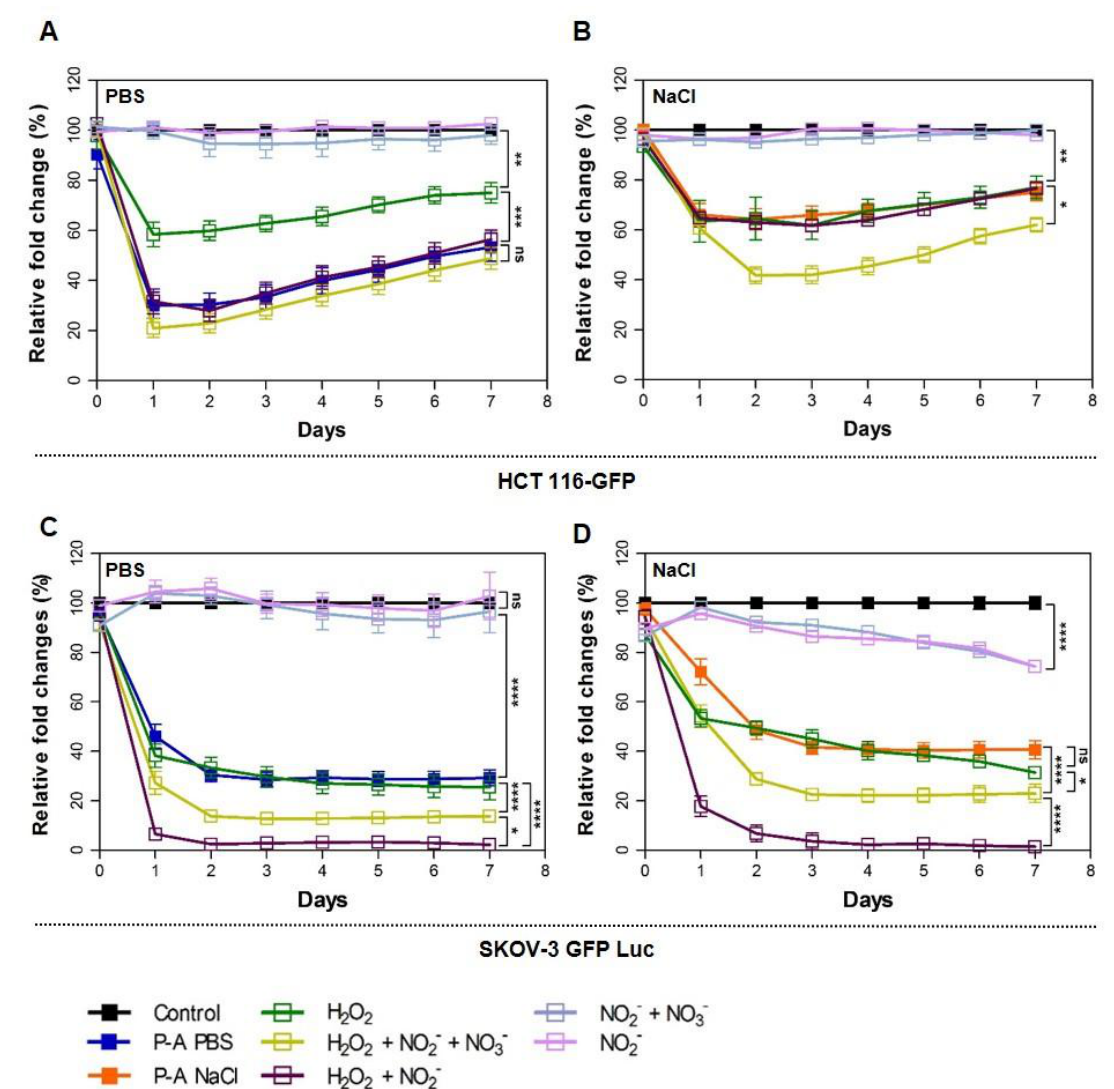
Figure 5. Spheroids’ treatment with long-lived reactive oxygen and nitrogen species (RONS): hydrogen peroxide (H 2 O 2 ) ± nitrite (NO 2 − ) ± nitrate (NO 3 − ). Growth curves of spheroids incubated 4 h in PBS (control), plasma-activated PBS (P-A PBS), PBS containing 680 µ M of hydrogen peroxide ± nitrite (360 µ M) ± nitrate (315 µ M) ( A and C for HCT 116-GFP and SKOV-3 GFP Luc, respectively) or NaCl solution (control), plasma-activated NaCl ( P-A NaCl), NaCl containing 515 µ M of hydrogen peroxide ± nitrite (160 µ M) ± nitrate (180 µ M) ( B and D for HCT 116-GFP and SKOV-3 GFP Luc, respectively). Graphs represent a relative fold change of spheroids’ equatorial area over the control in percentage as a function of time. Areas were measured from the GFP fluorescence micrographs. Untreated spheroids of HCT 116-GFP (A,B) or SKOV-3 Luc GFP (C,D) are referred to as “control”. Two-way ANOVA, **** p < 0.0001; *** p < 0.001; ** p < 0.01;* p < 0.05; N = 3 independent experiments with n = 6 spheroids per experiment for HCT 116-GFP and N = 2 independent experiments with n = 6 spheroids per experiment for SKOV-3 GFP